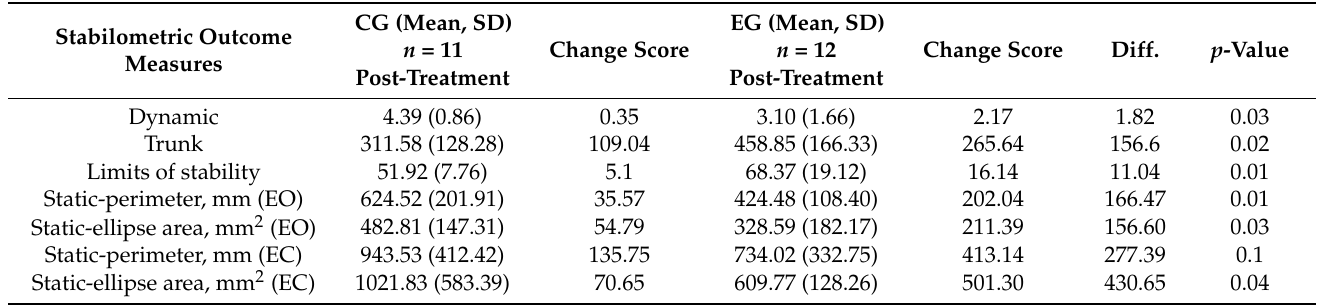
Table 4. Comparison of change score of stabilometric outcome measures between CG and EG post-treatment.